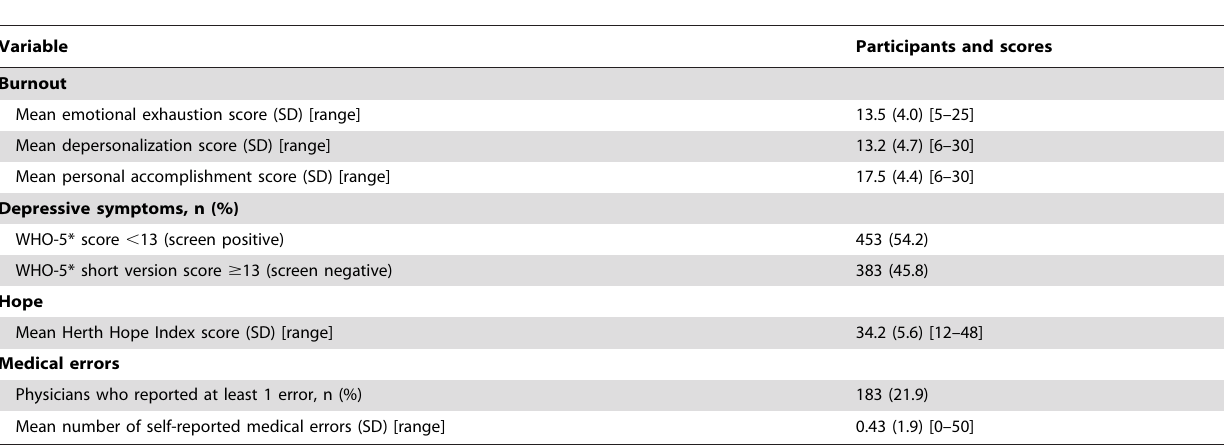
Table 2. Self-reported medical errors, burnout, and depression among male and female practicing physicians.